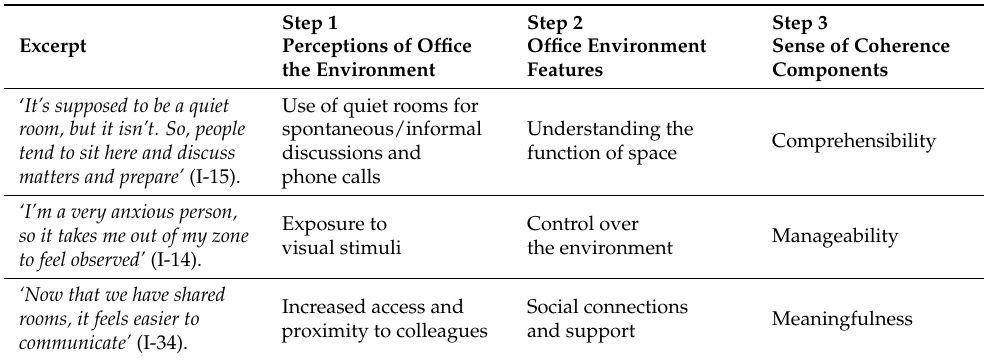
Table 3. Interview coding